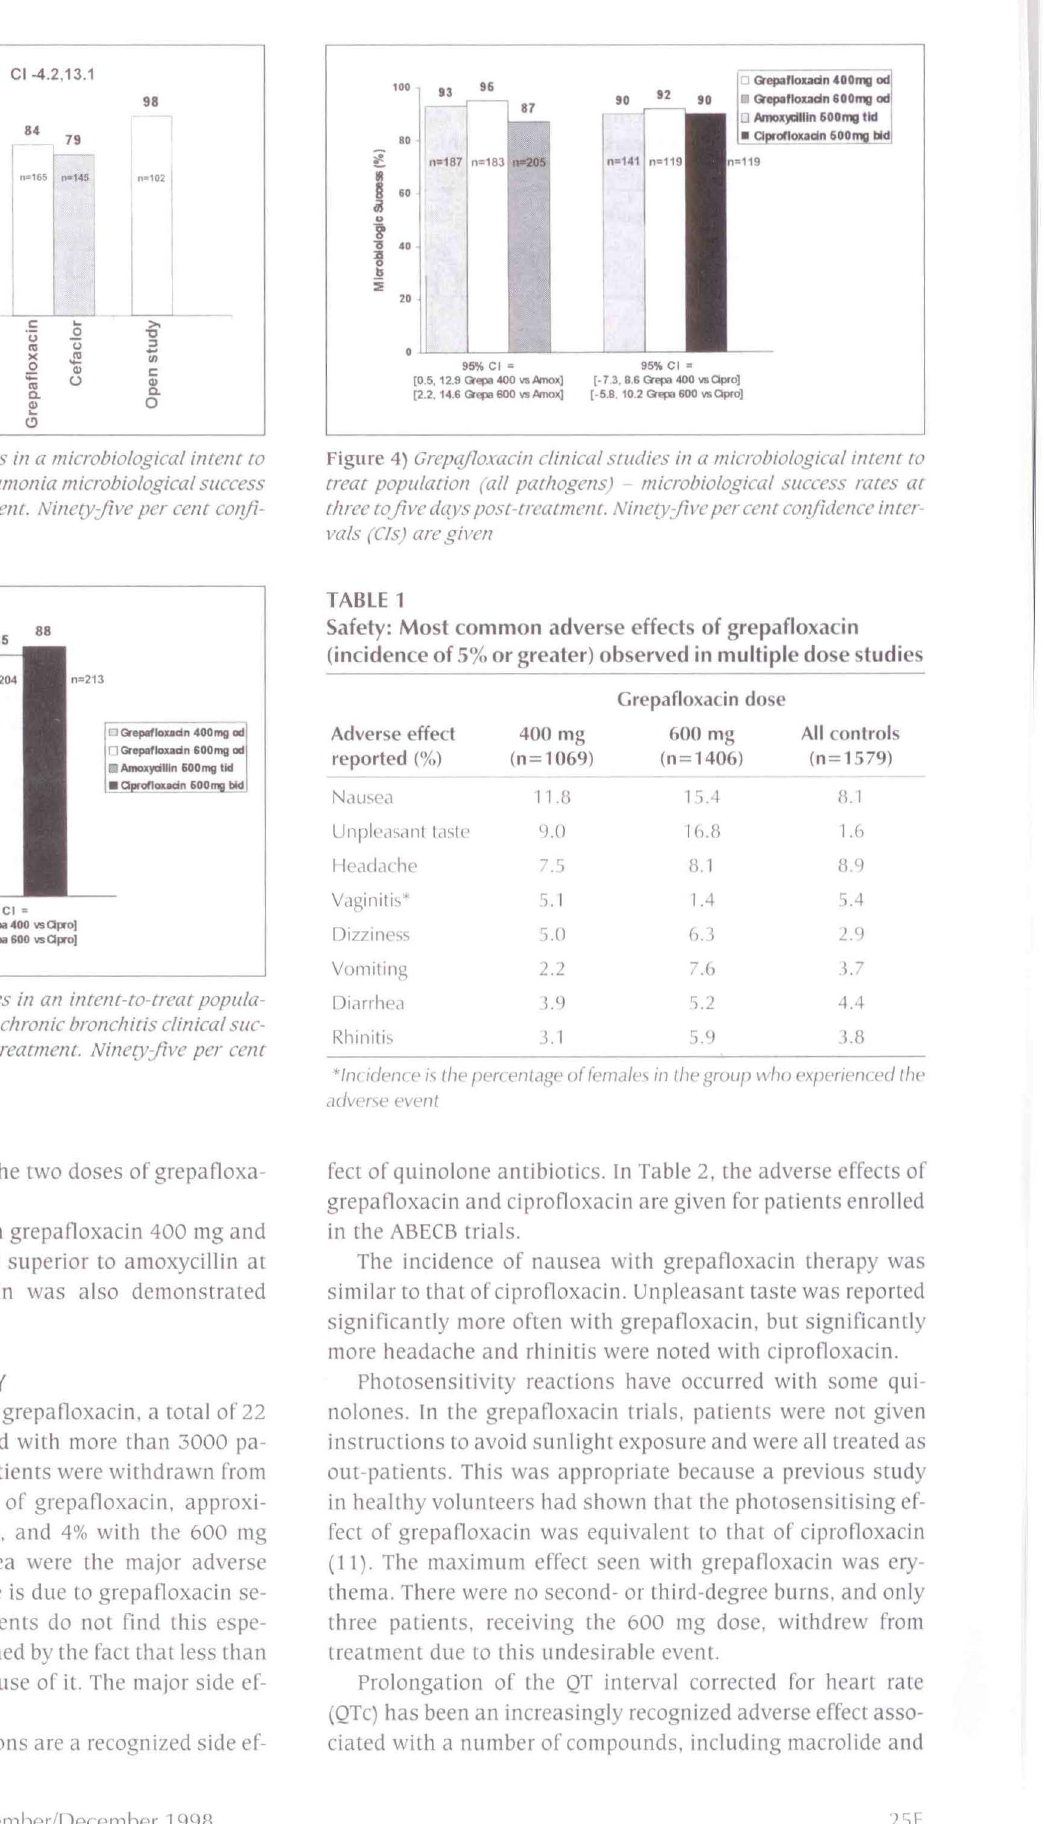
Figure 2) Grepefloxacin clinical studies in a microbiological inte11t ro treat populatio11 (all pathogens) - pneumonia microbiological succes rates at three to.five days post-treatment. Ninetyjive per cem co1J!i de11cc ince,vals (Cfs) arc givc11